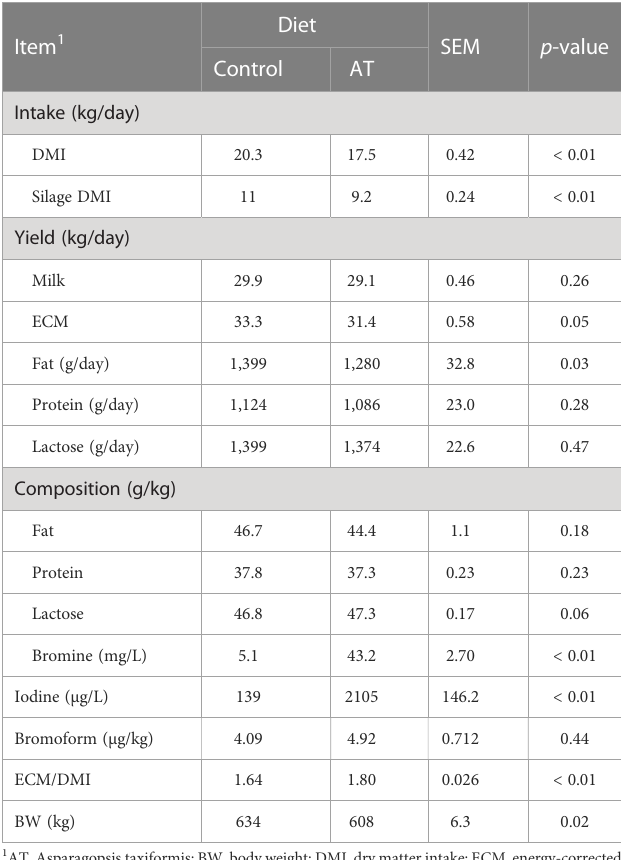
TABLE 1 Dietary ingredient composition and grass silage fermentation quality [g/kg dry matter (DM) unless otherwise stated]. Item